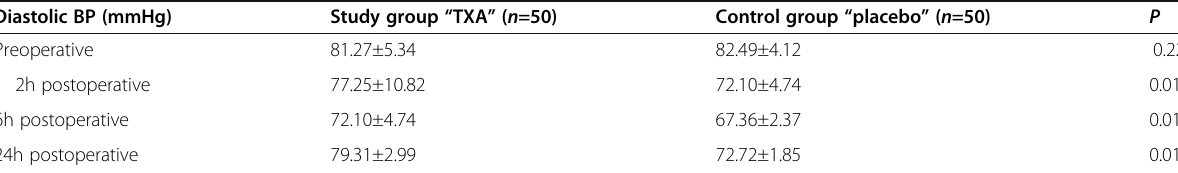
Table 7 Diastolic blood pressure (mmHg) in both groups all through the procedure Diastolic BP (mmHg)